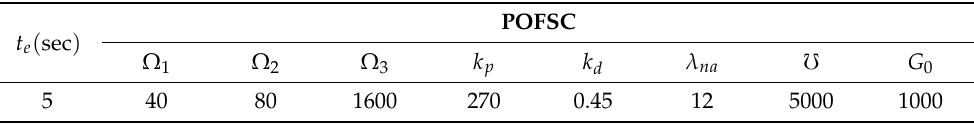
Figure 13. Results of fifth-order path-tracking positioning for shoulder joint flexion angles of 30 ◦ and 45 ◦ . ( a ) System response, ( b ) tracking error, and ( c ) control voltage. Table 3. Parameters of the proposed POFSC in fifth-order path-tracking positioning control for the shoulder